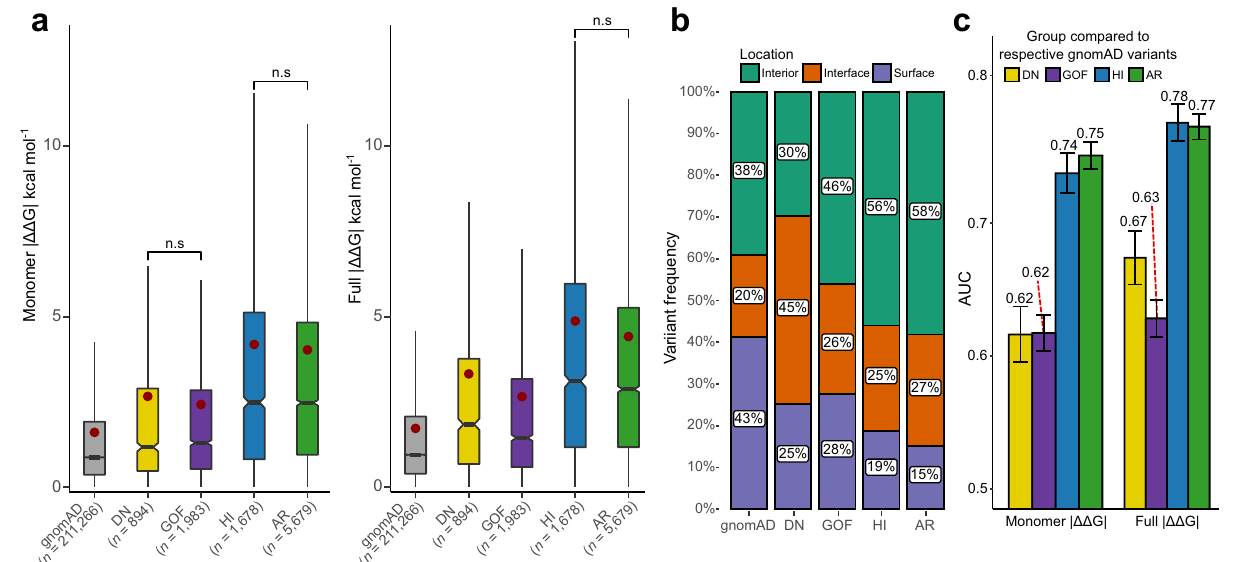
Fig. 3 Gain-of-function and dominant-negative mutations are milder than loss-of-function mutations. a Comparison of predicted | ΔΔ G | values for gnomAD variants and pathogenic ClinVar mutations from AD genes classi fi ed as dominant negative (DN), gain of function (GOF) and haploinsuf fi cient (HI), and pathogenic ClinVar mutations from AR genes. Boxes denote data within 25th and 75th percentiles, and contain median (middle line) and mean (red dot) value notations. Whiskers extend from the box to furthest values within 1.5x the inter-quartile range. Pairwise group comparisons are signi fi cant (p < 0.001, two-sided Holm-corrected Dunn ’ s test) unless speci fi ed (n.s., p -values in order from left to right: 0.786, 0.321, 0.075). b Proportions of different types of mutations occurring in protein interiors, surfaces and interfaces. All pairwise proportion comparisons via Chi-square test are signi fi cant, with the lowest effect size being noted for HI vs AR (Cramer ’ s V = 0.04, compared to 0.20 and 0.26 for DN vs. HI, and DN vs. AR, respectively). c AUC values calculated from ROC curves for discriminating between different types of pathogenic ClinVar mutations, and putatively benign gnomAD variants. Only homozygous gnomAD variants were included for the AR analysis. Error bars denote 95% con fi dence intervals. Source data are provided as a Source Data fi